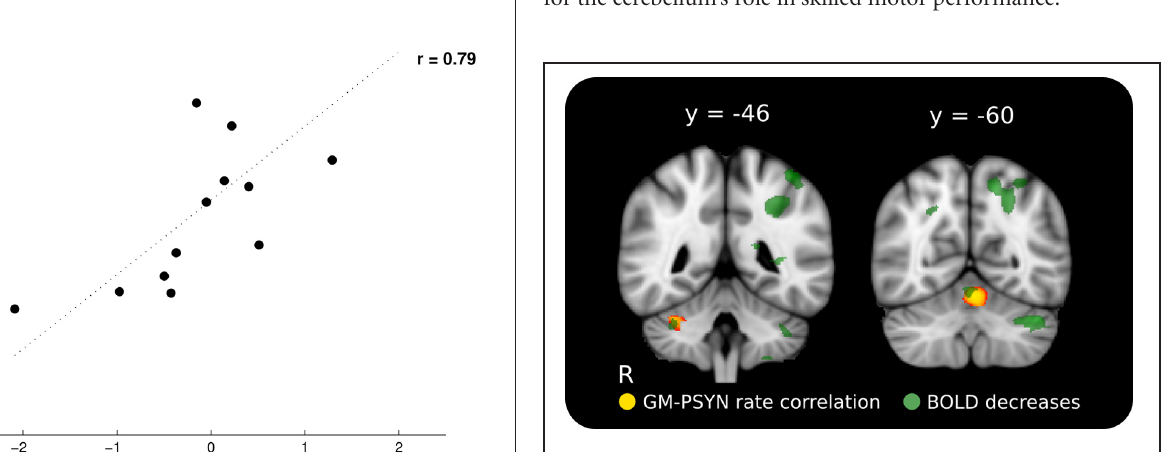
FIGURE 5 | Positive relationship between rate of improvement on synchronization and GM volume in cerebellar lobules HVI and V. The cerebellar structures identified here correspond well with two regions where BOLD activity decreased across learning on this task. Red-Yellow: significant correlation between GM volume and rate of improvement ( p < 0 . 05, corrected for multiple comparisons); Semi-Transparent Green: task-specific decrease in BOLD activity between Day 2 and Day 5 ( p < 0 . 001, cluster corrected). Significant regions are overlaid on the ICBM 152 T1 average for display.